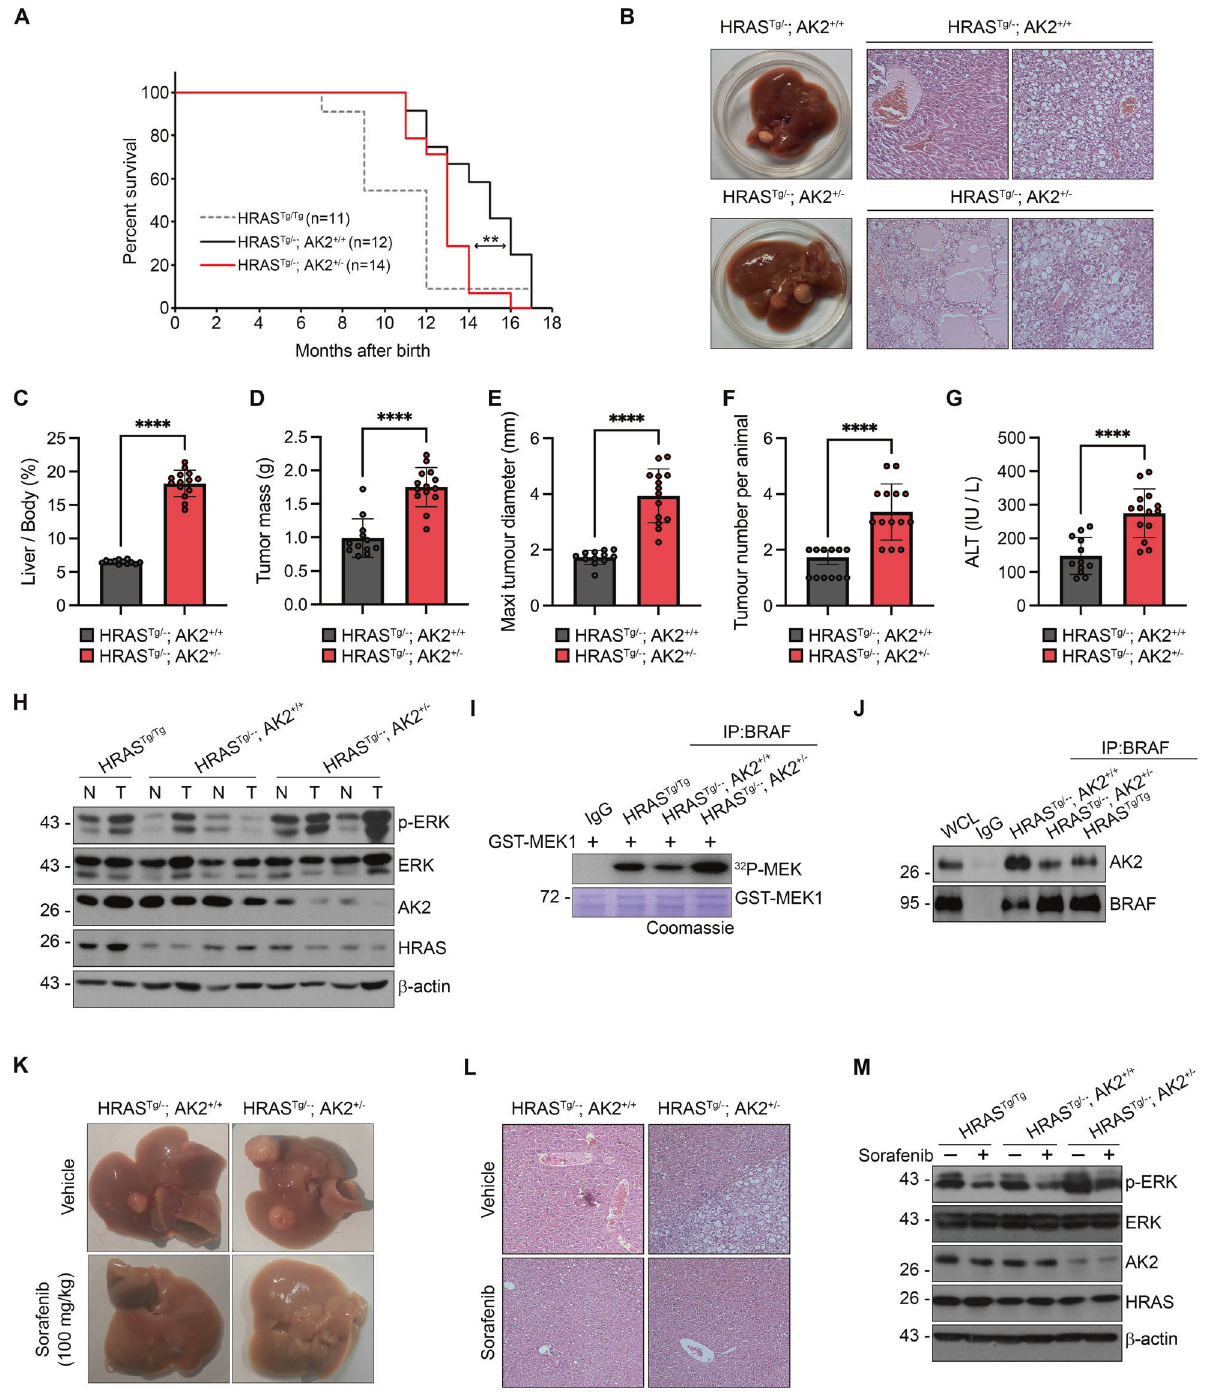
Fig. 5 AK2 ablation exacerbates tumor formation in HRAS G12V mouse model of HCC. A Reduced survival of HRAS G12V + / − mice by AK2 + / − de fi ciency. Survival curves of HRAS G12V + / − : AK2 + / + ( n = 12, HRAS Tg/ − ; AK2 + / + ), HRAS G12V + / − : AK2 + / − ( n = 14, HRAS Tg/ − ; AK2 + / − ), and HRAS G12V + / + ( n = 11, HRAS Tg/Tg ) mice with median survival of 450, 360, and 300 days, respectively. ** p = 0.001172 by log-rank test. B Pathology of liver tumor by AK2 + / − de fi ciency. Gross histology (left) and representative H&E staining of paraf fi n-embedded liver sections (right) obtained from HRAS G12V + / − : AK2 + / + (HRAS Tg/ − ; AK2 + / + ) and HRAS G12V + / − : AK2 + / − (HRAS Tg/ − ; AK2 + / − ) mice at 8 months of age. C – G High incidence of liver tumor by AK2 + / − de fi ciency. After tumors had grown to the approved size, the liver/body weight ratios ( C ), liver tumor volumes ( D ), maximal diameters ( E ), average tumor burden ( F ), and circulating blood levels of ALT ( G ) were quanti fi ed. Values are mean ± S.E.M. ( n = 12, 14 for each HRAS G12V + / − : AK2 + / + and HRAS G12V + / − : AK2 + / − ; * p < 0.05, ** p < 0.01, *** p < 0.001, *** p < 0.0001); paired Student ’ s t-test. H – J Combinations of HRAS G12V and AK2 + / − alleles amplify the ERK activity. Liver tumor extracts of HRAS G12V + / − : AK2 + / + (HRAS Tg/ − ; AK2 + / + ), HRAS G12V + / − : AK2 + / − (HRAS Tg/ − ; AK2 + / − ), and HRAS G12V + / + (HRAS Tg/Tg ) mice in ( B ) were analyzed with western blotting ( H ) and immunoprecipitation (IP) assay ( J ) followed by kinase reaction with γ - 32 p-MEK1 ( I ). Total β -actin was used as a loading control. K − M Sorafenib retards tumor growth in 7-month-old HRAS G12V + / − : AK2 + / − mice. HRAS G12V + / − : AK2 + / + (HRAS Tg/ − ; AK2 + / + ) and HRAS G12V + / − : AK2 + / − (HRAS Tg/ − ; AK2 + / − ) mice were daily treated with 100mgkg − 1 body weight Sorafenib for 3 weeks. Gross appearances of livers lesions ( K ) and representative H&E staining of paraf fi n-embedded liver sections ( L ) were examined in four groups of the mice. Liver tumor extracts were subjected to western blotting ( M ). Total β -actin was used as a loading control.